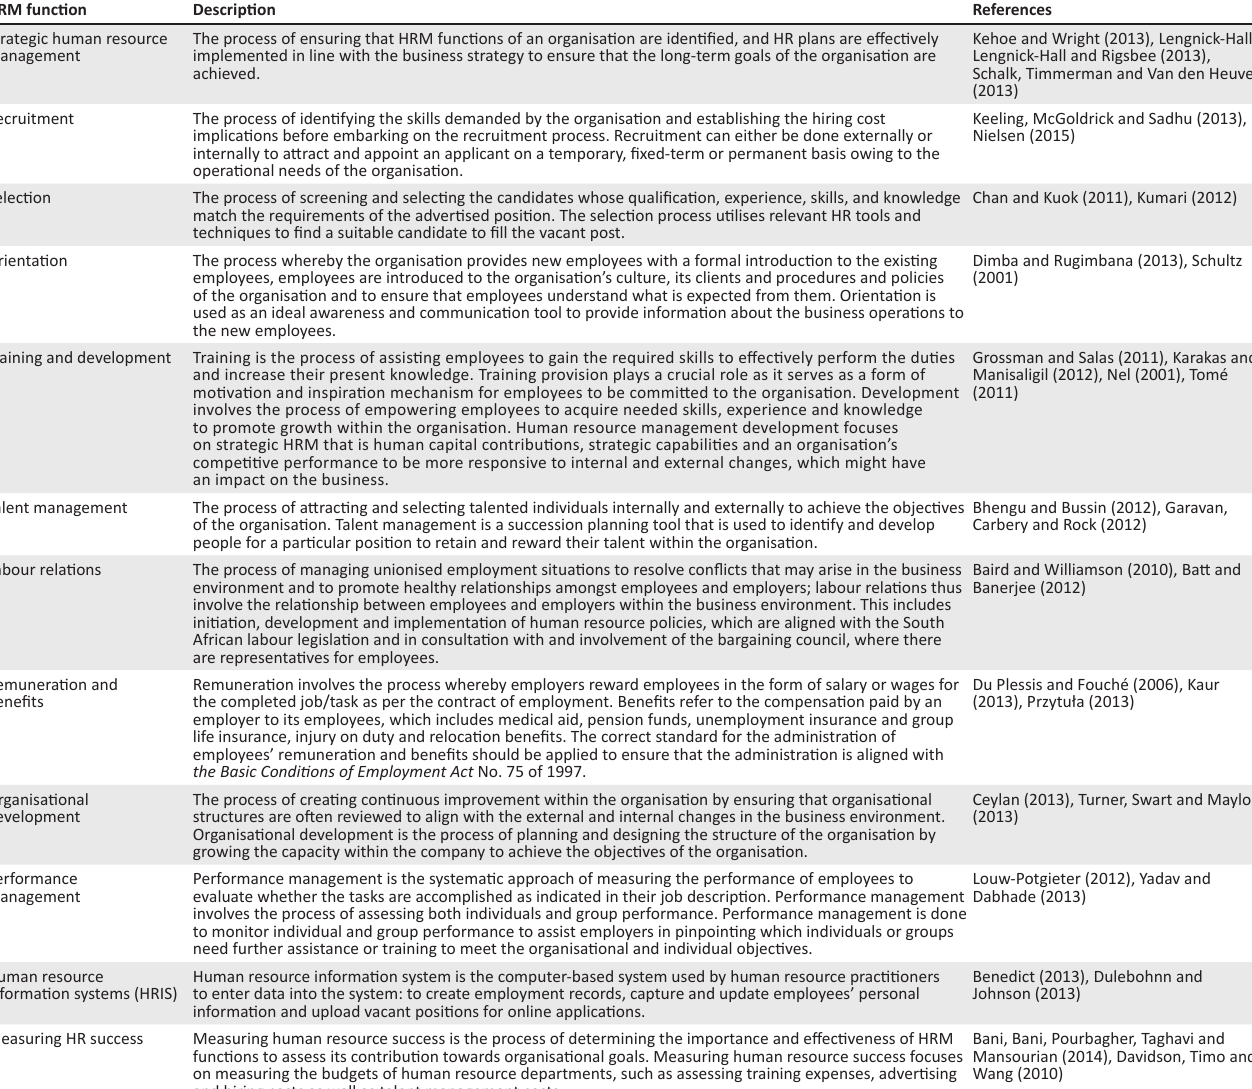
TABLE 1: Human resource management functions as categorised by the South African Board for People